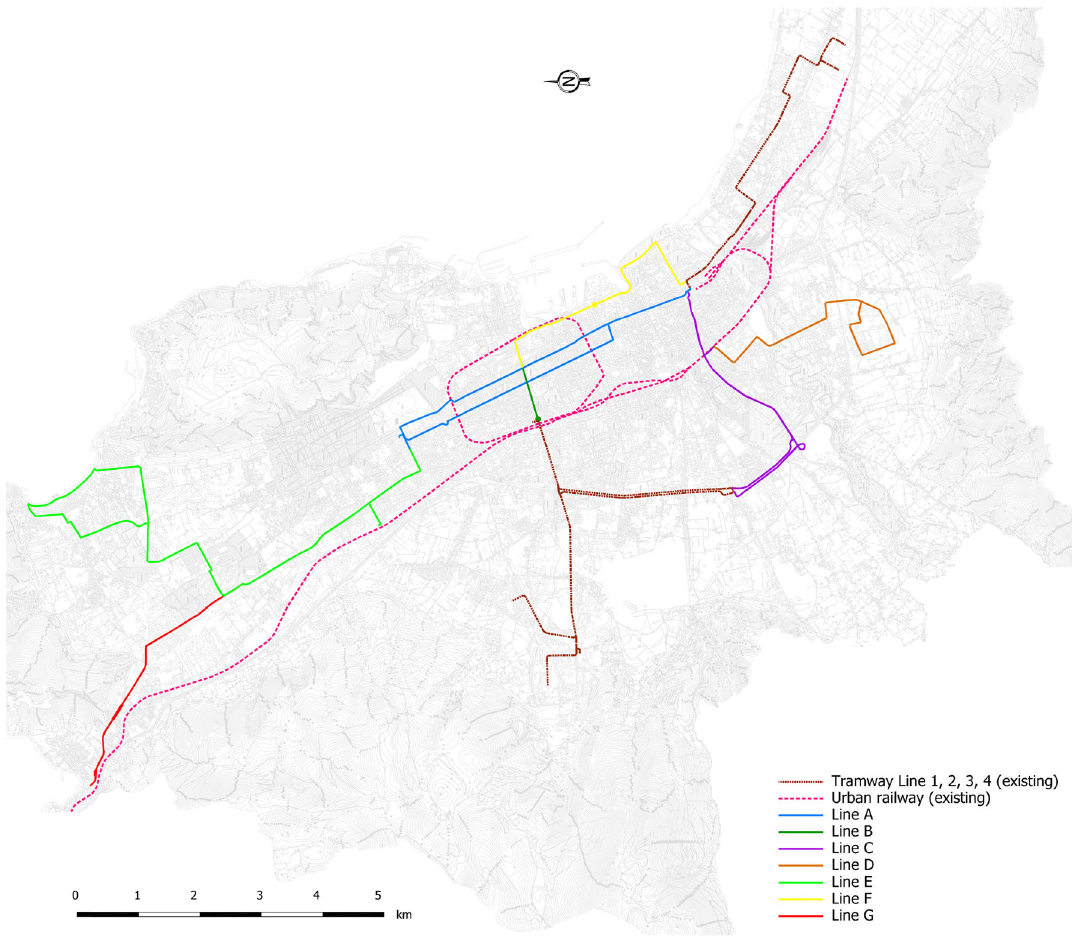
Fig. 4 Future tramway network in Palermo (overlap between current and new